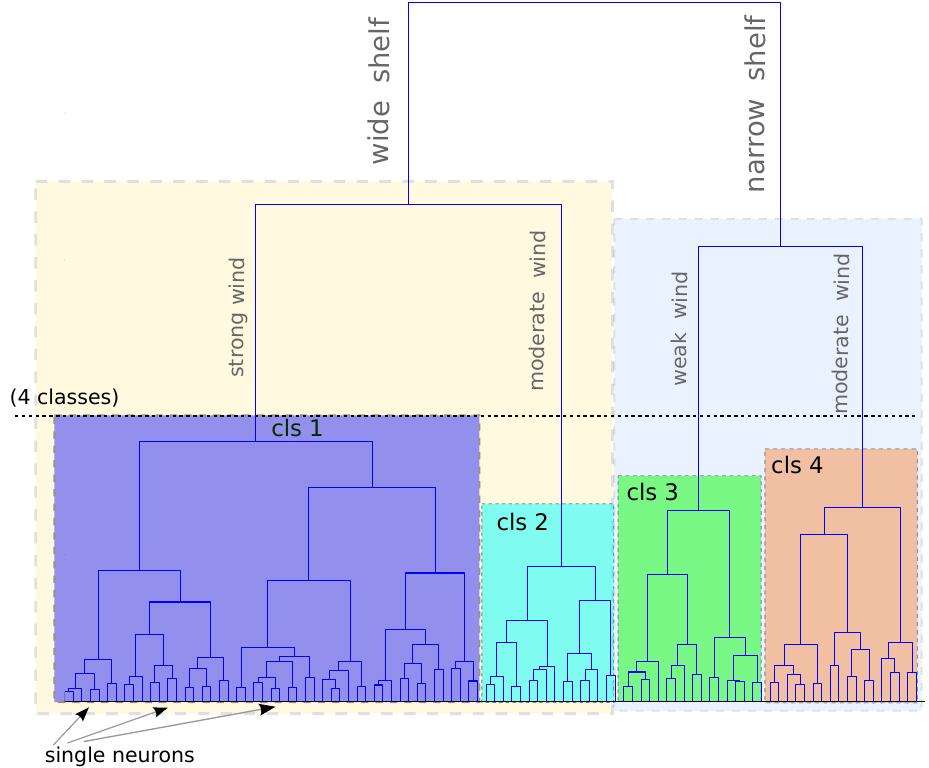
Fig. 7. HAC dendrogram showing the hierarchy of the clusters. The dendrogram was cut where the gap between two successive mergers is the largest resulting in 4 classes. They correspond to the following combinations of shelf width and wind strength: strong wind-wide shelf (class 1), moderate wind-wide shelf (class 2), weak wind-narrow shelf (class 3), and moderate wind-narrow shelf (class 4).